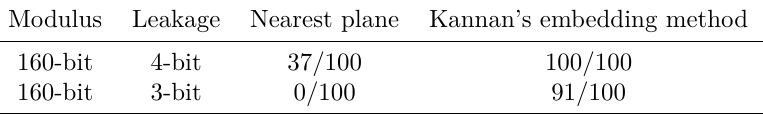
Table 5: A comparison of the CVP and SVP